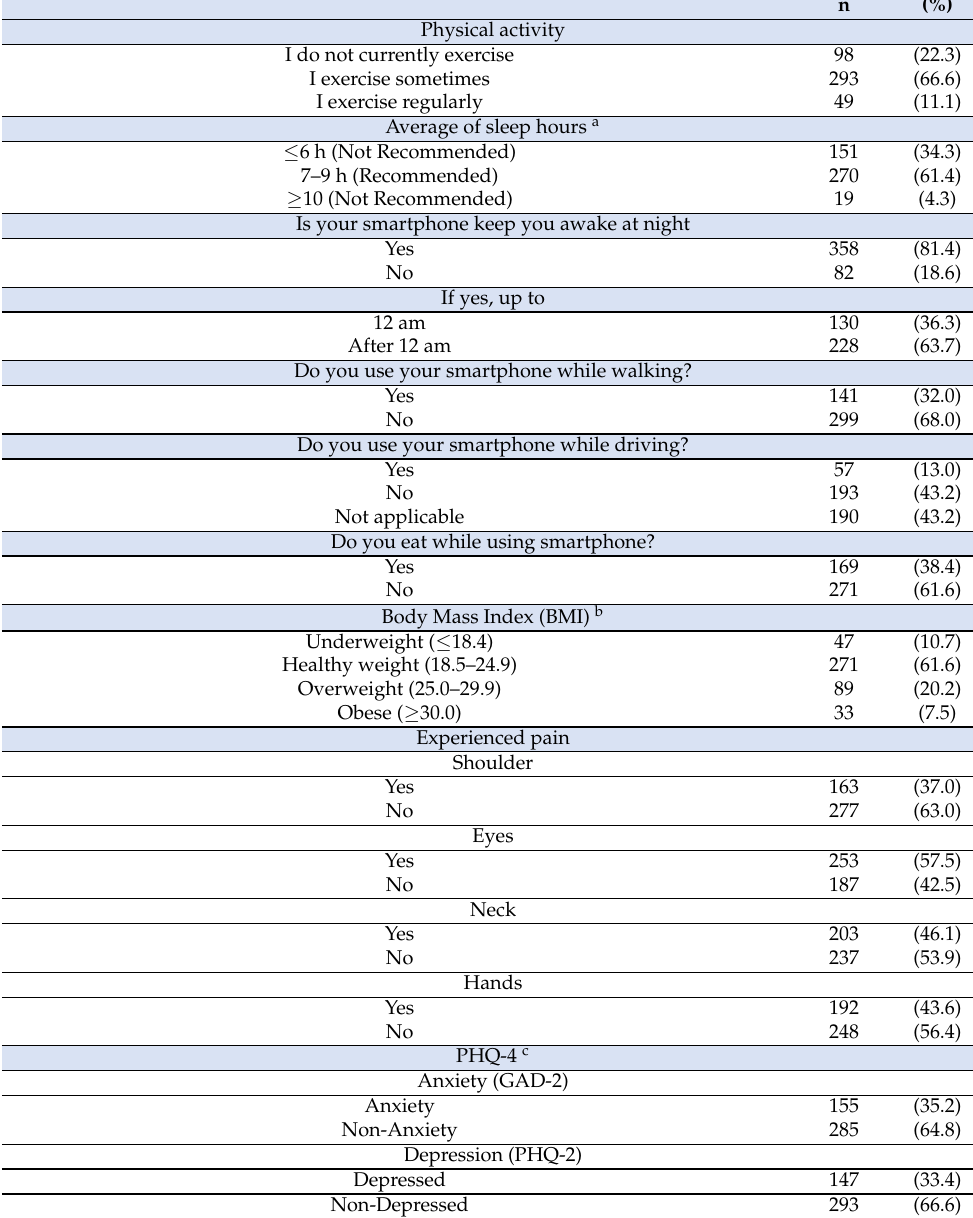
Table 2. Distribution of health characteristics, N =